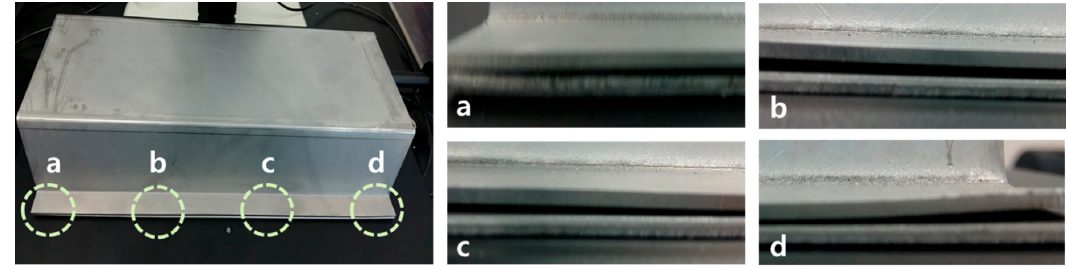
Figure 1. Part ‐ to ‐ part gap variation and angles of elevation and depression in a simplified side ‐ Figure 1. Part-to-part gap variation and angles of elevation and depression in a simplified side-member member part assembly. part assembly.